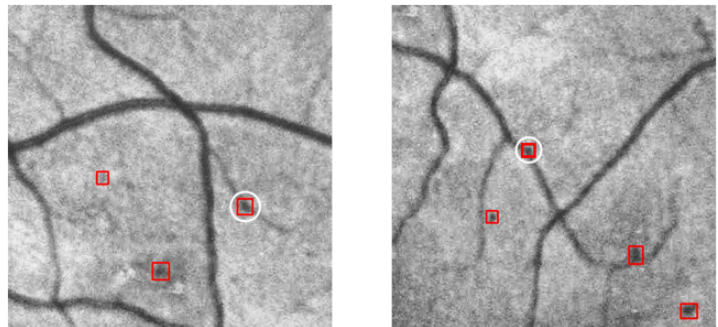
Figure 10. Screening out false detections using spatial confidence. Instances showing an excessive distance between the target and the nearest blood vessel are screened out. The two examples shown in this figure represent another typical source of false detections with our method. These areas are treated as target objects because some pixel points on a blood vessel are darker than their surrounding